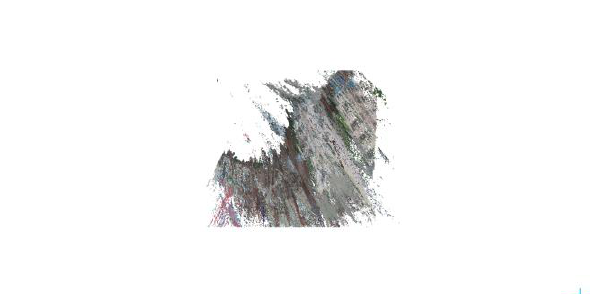
Figure 3. Lateral view of the point cloud obtained from 91 frames, with clearly visible